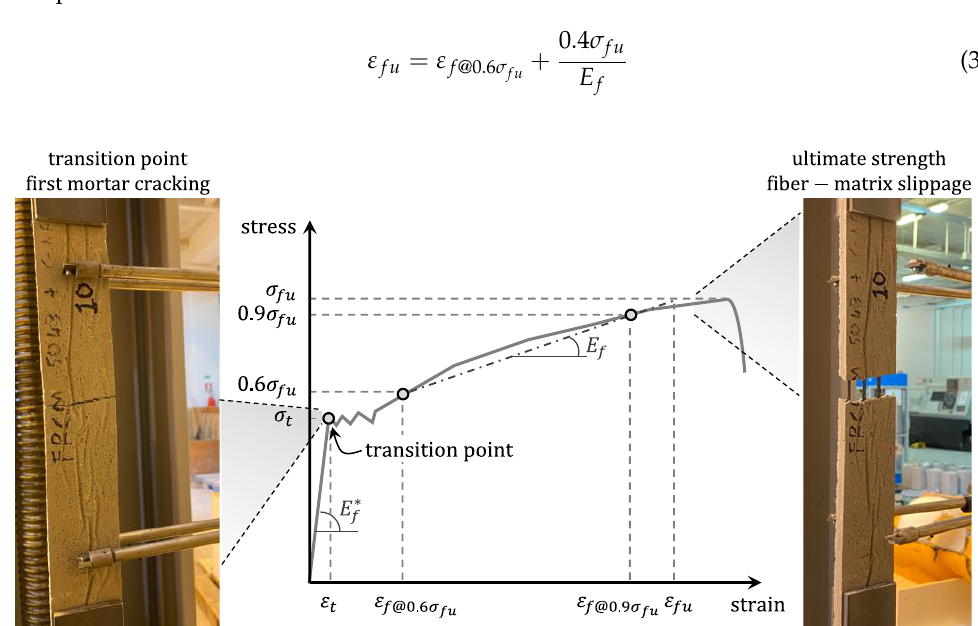
Figure 7. Schematic results of clevis-grip tensile tests and identification of characteristic points and mechanical parameters according to AC434 guidelines [28].